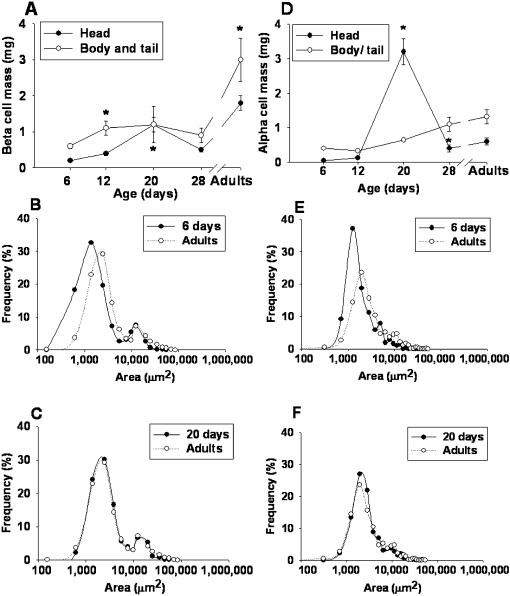
Structural changes of pancreatic beta and alpha cells during the first month of life.
(A) The mass of beta cells in the head and tail of the gland.
(B) Frequency distribution of beta cell aggregates at d6 and d90.
(C) Comparison between d20 and d90.Data were pooled from 8 rats, n  =  9 216 beta cell aggregates measured.
(D) Mass of alpha cells in the head and tail during the first month of life.
(E, F) Frequency distribution of the size of alpha cell aggregates at d6, d20 and d90.
(E) Comparisons between d6 and d90. (F) Comparisons between d20 and d90.Data were pooled from 4 rats, n  =  1 739 alpha cell aggregates measured, are expressed as mean ± SEM.Symbols denote statistically significant differences: (*) p < 0.05 with respect to previous age.